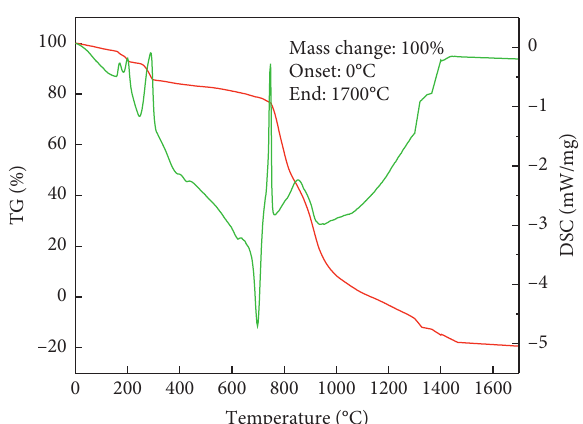
Figure 3: TG-DSC curves of (Ti, W Mo, Ta) (C, N) solid solution